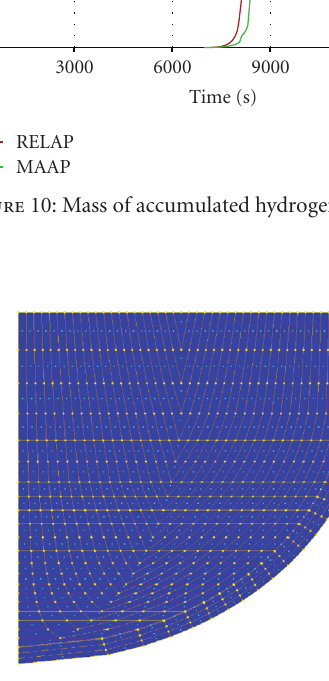
Figure 11: COUPLE model of the NEK RPV lower head.